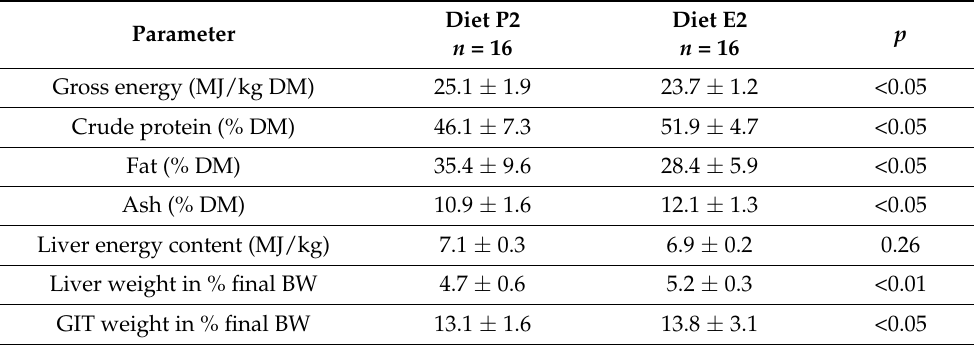
Table 5. Results of the carcass analysis from trial 2 (mean ± SD (g)). BW = body weight; GIT = gas- trointestinal